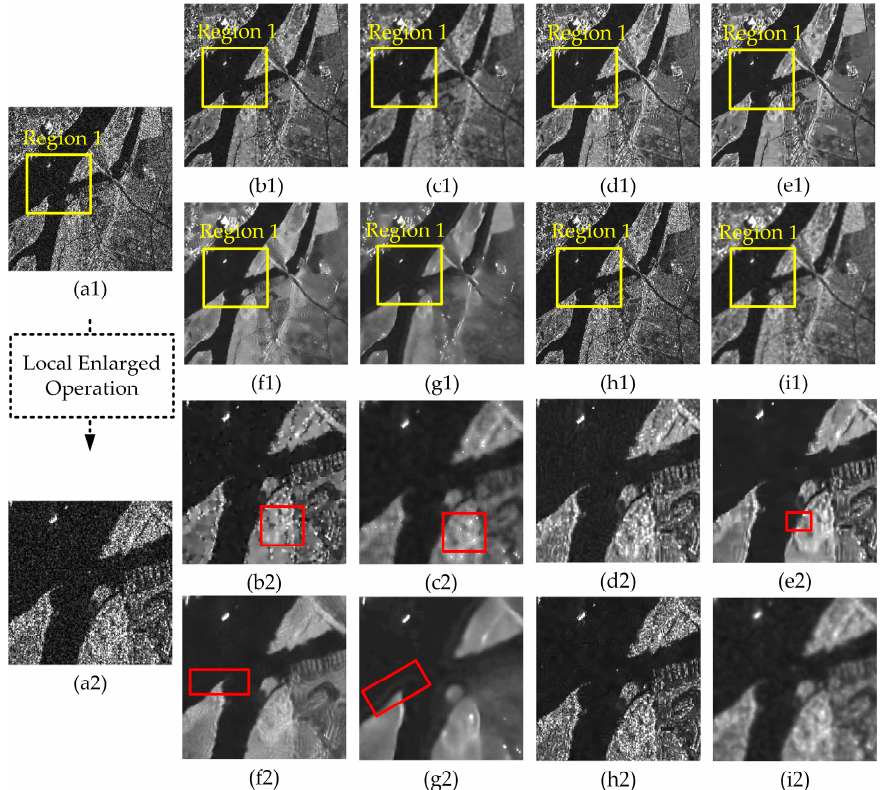
Figure 12. ( a1 ) RadarSAT-2 original image. Images filtered by ( b1 ) DPAD, ( c1 ) EnLee, ( d1 ) SAR-BM3-D, ( e1 ) FANS, ( f1 ) PPB, ( g1 ) DnCNN, ( h1 ) NL-means, and ( i1 ) MDLPIA-NLM filters. ( a2 – i2 ) Locally enlarged images of region 1 of ( a1 – i1 ), respectively. The red box and circle are areas for further observation.